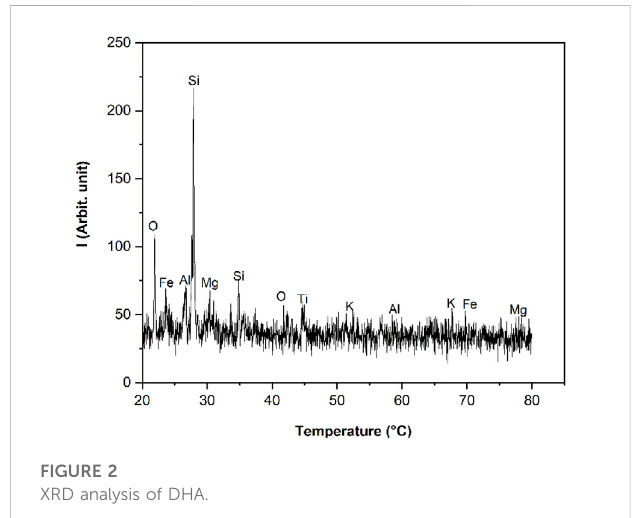
FIGURE 2 XRD analysis of